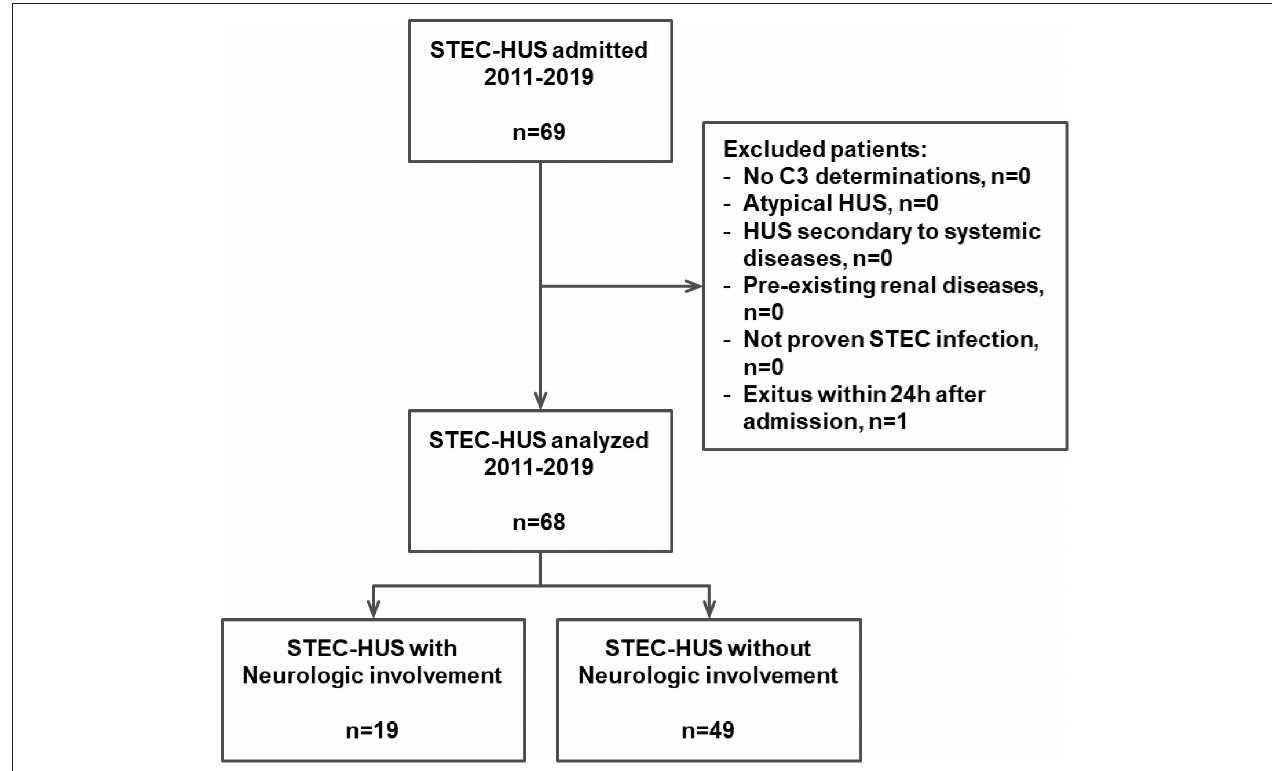
FIGURE 1 | Algorithm of the study. STEC, Shiga toxin-producing Escherichia coli ; HUS, hemolytic uremic